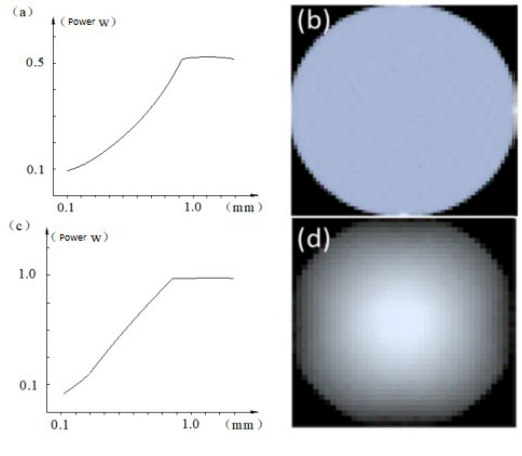
Figure 5 Spot energy